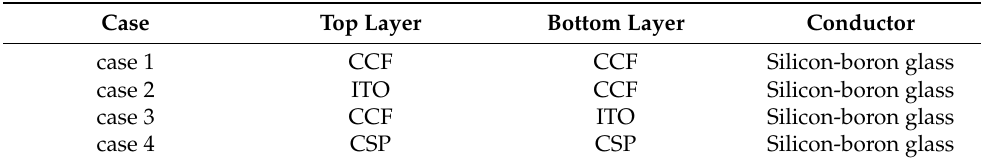
Table 2. Composition of the 4 types of glass